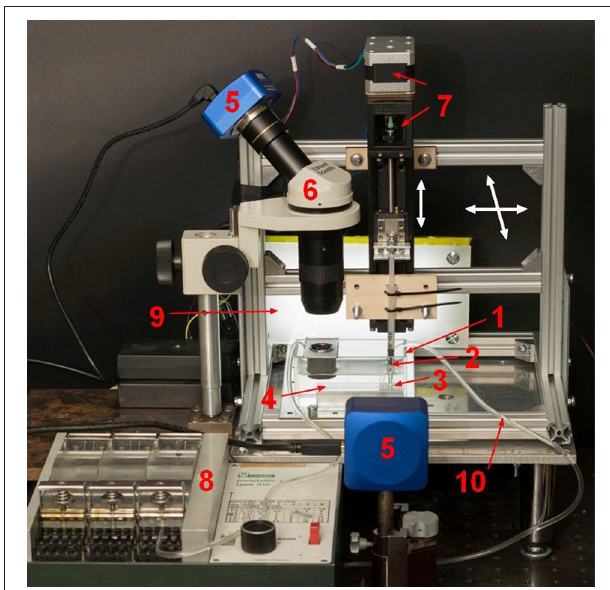
FIGURE 4 | Elements of the automatic, captive bubble CA determination system (for description see